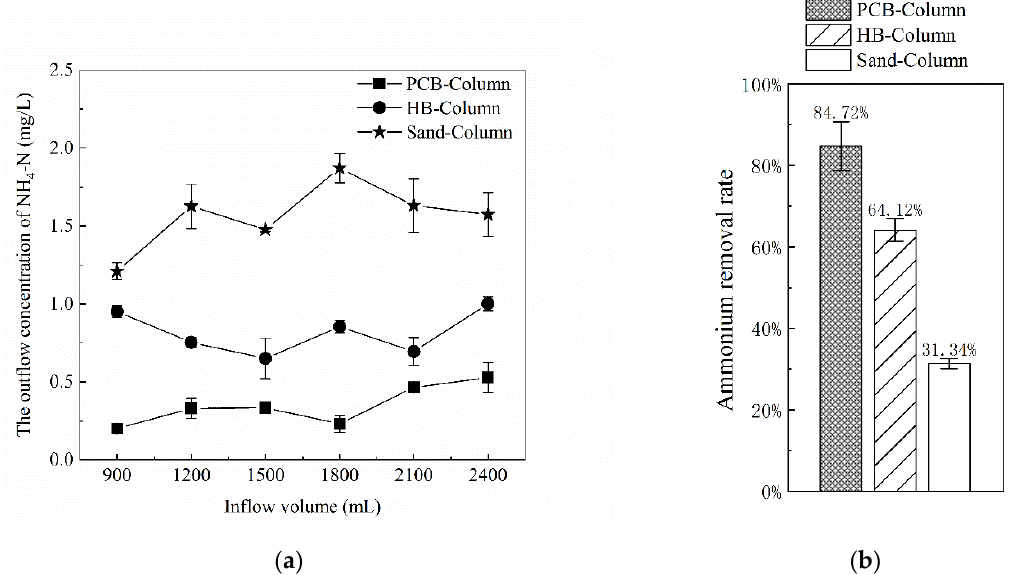
Figure 8. Concentration and mean removal rates of NH 4+ in outflows from the three columns in the second simulated rainfall event. ( a ) The outflow concentrations of NH 4+ from the three columns; and ( b ) the mean removal rates of NH 4+ from the three columns.